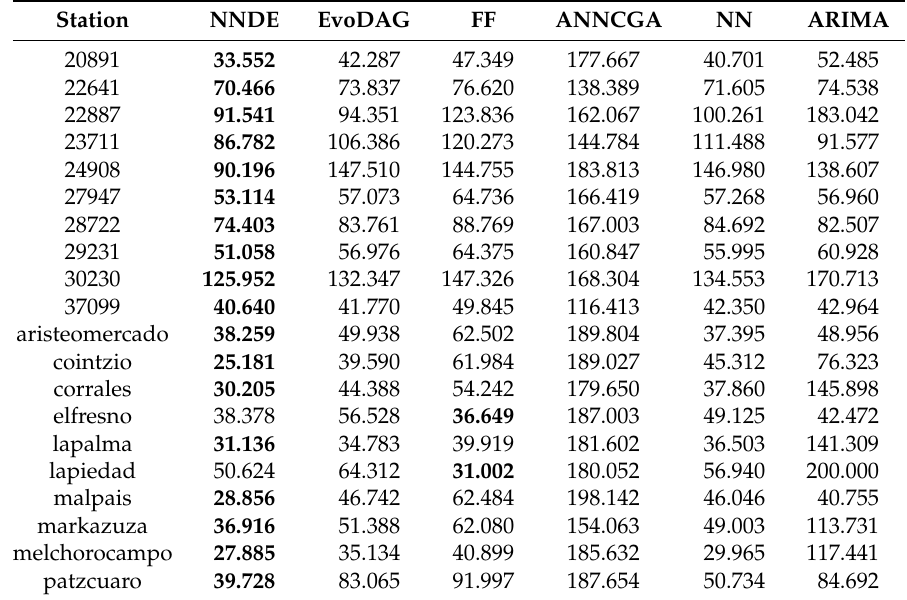
Table 3. SMAPE results for One Day Ahead (ODA) forecasting. Bold indicate the winning